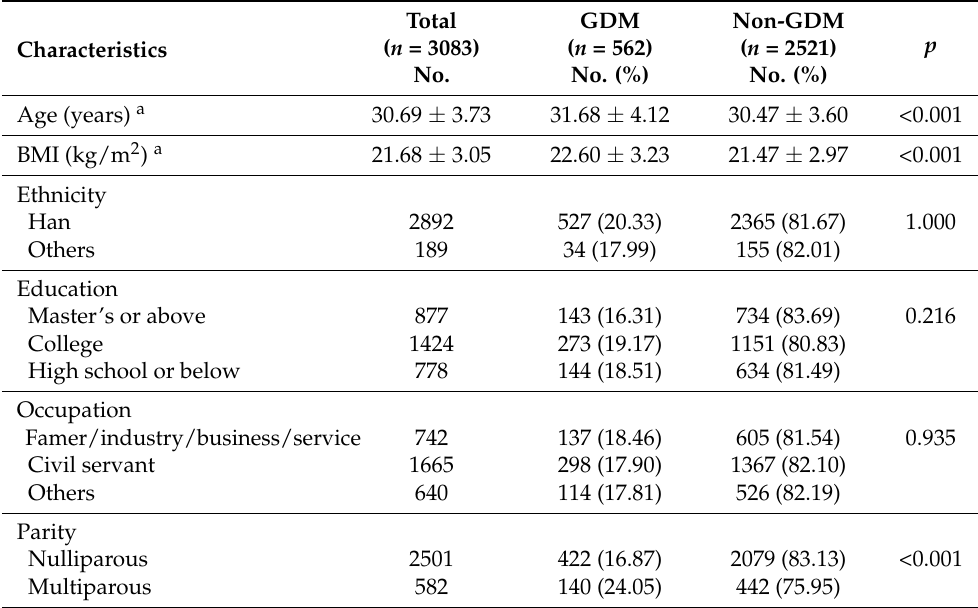
Table 1. The characteristics of pregnant women by blood glucose in